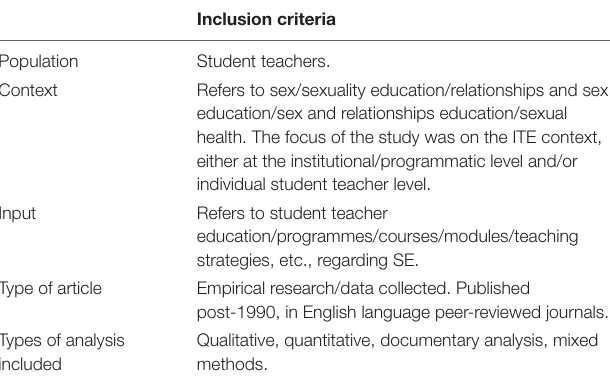
TABLE 1 | Screening and selection